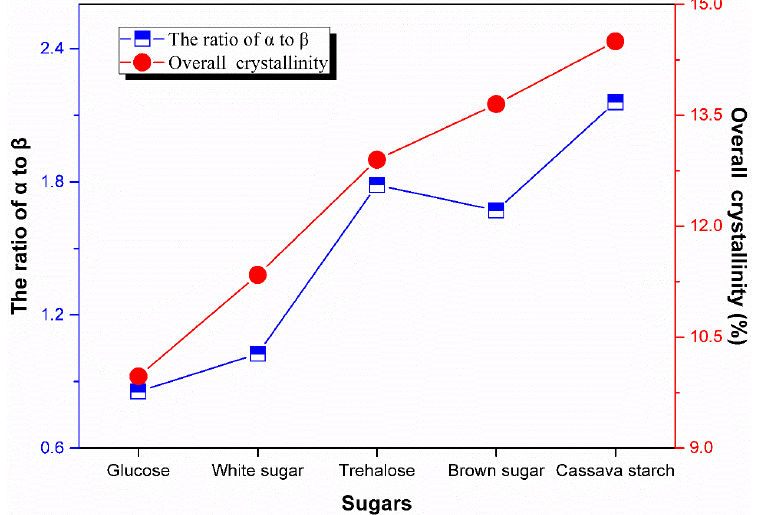
Figure 12. Effect of sugars on the ratio of α to β and overall crystallinity.